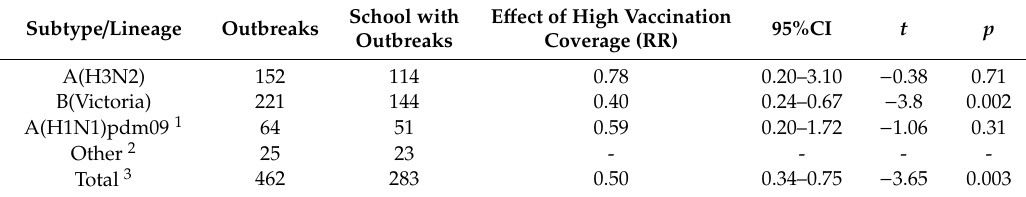
Table 4. E ff ect of vaccine on febrile outbreaks caused by di ff erent influenza virus subtype / lineage, based on a two-level random e ff ect zero-inflated negative binomial (RE-ZINB) regression model.